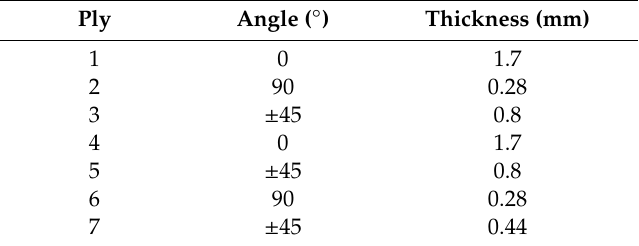
Table 4. Predicted ply thickness.